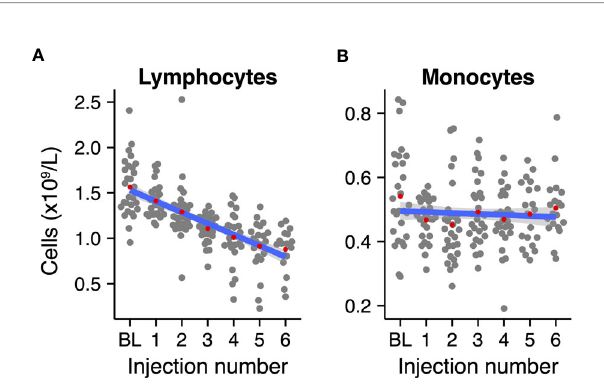
FIGURE 1 | Normalized absolute mononuclear cell counts during radium-223 treatment. (A) Lymphocyte and (B) monocyte counts at baseline (BL) and after each radium-223 injection. Red dots indicate the group means. The blue line represents the fi tted linear regression model, including 95%